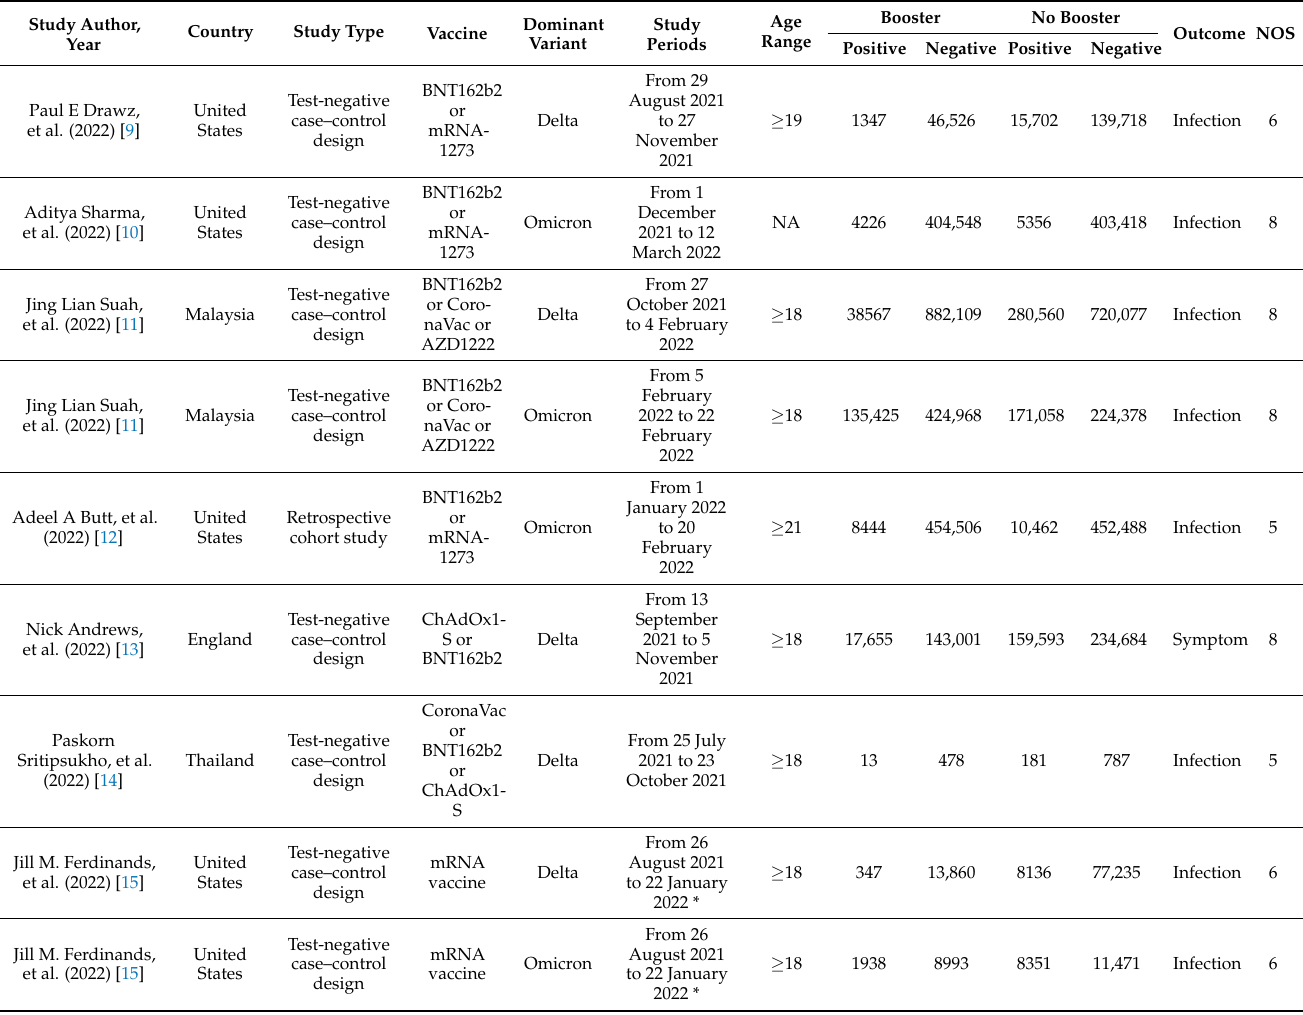
Table 1. Characteristics of the included